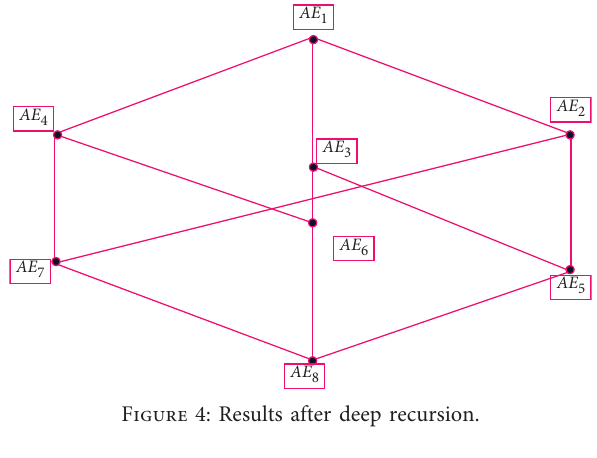
Figure 4: Results after deep